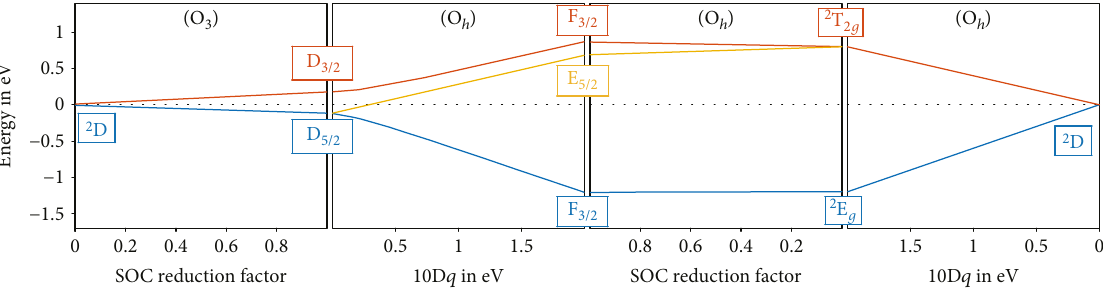
Figure 2: Initial state term schemes for Cu 2+ (3d 9 ) illustrating the e ff ect of the 3d SOC ζ splittings of the atomic ground state term 2 D.